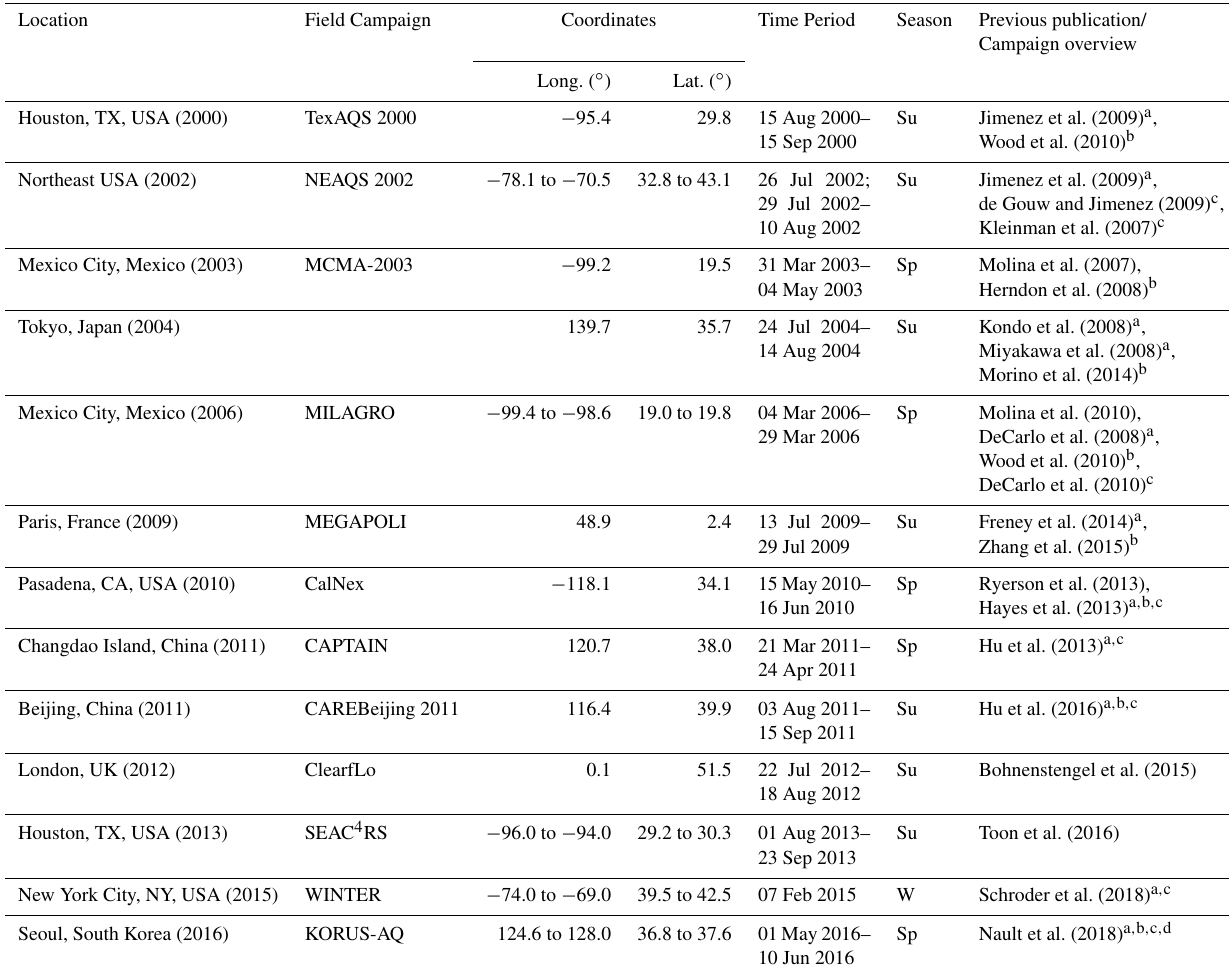
Table 1. List of campaigns used here, and the values previously reported for these campaigns. “W” denotes winter, “Sp” denotes spring, and “Su” denotes